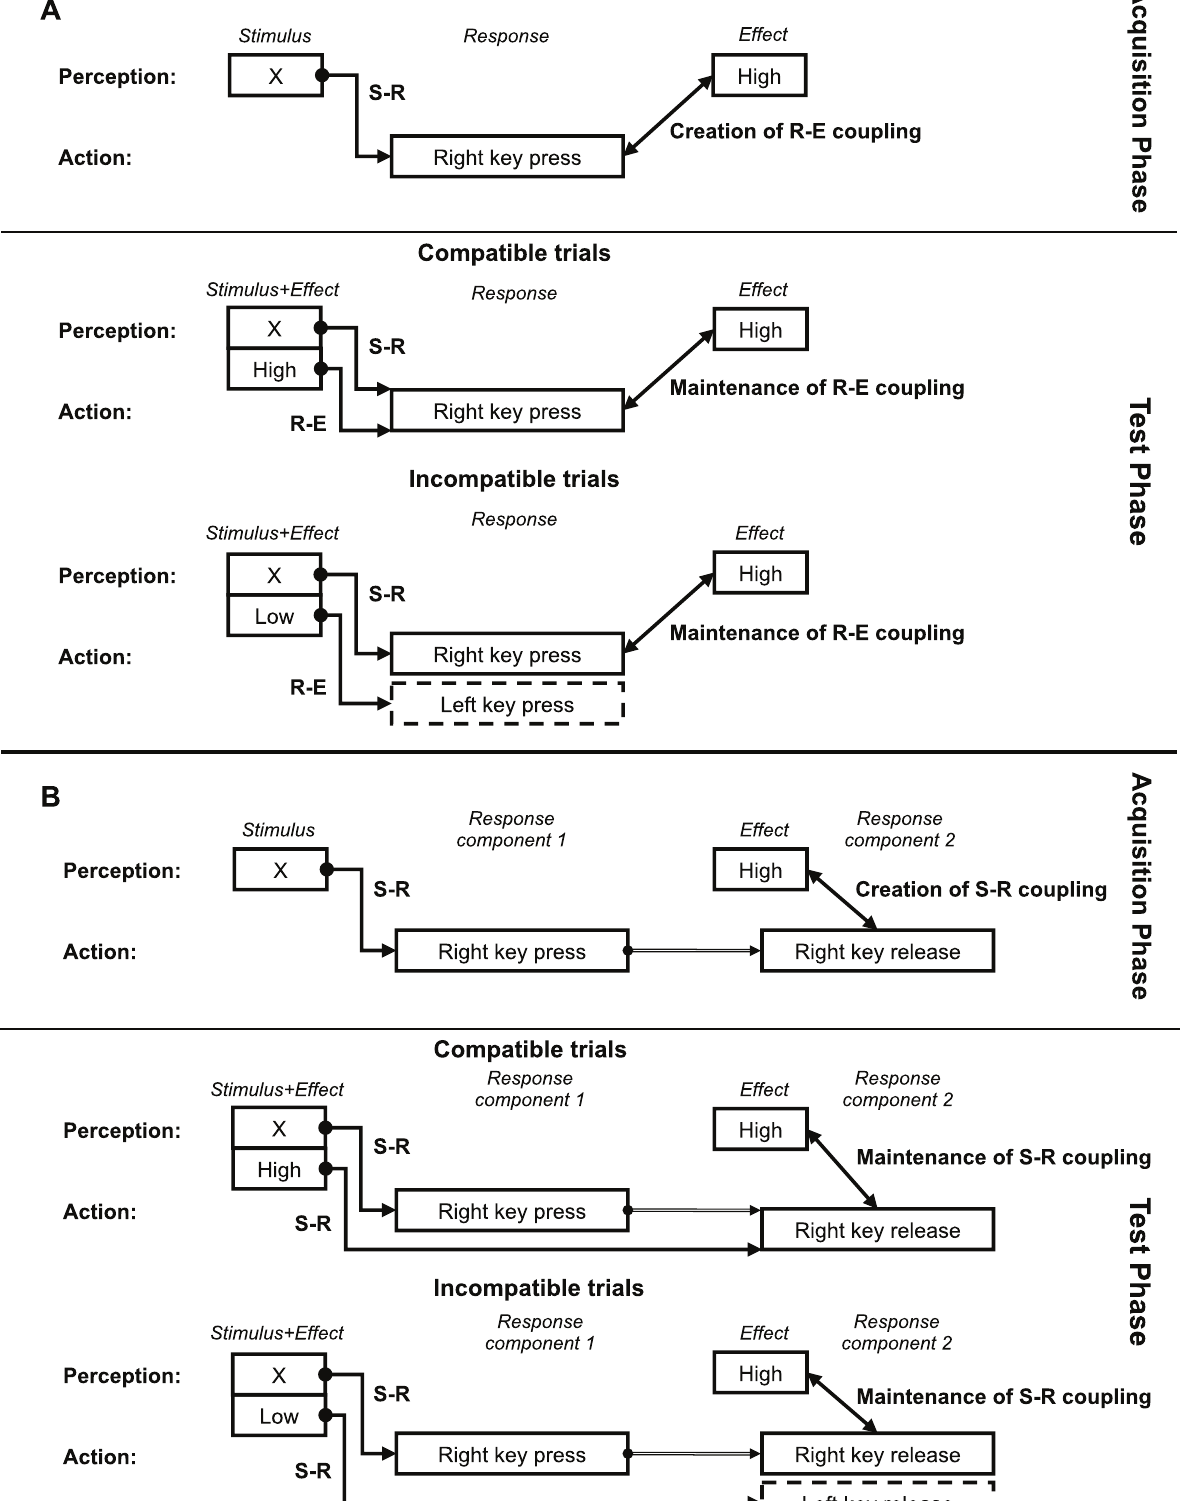
Figure 1. Outline of the two models. ( A ) Outline of the two-step model for the ideomotor principle (see e.g. [21]). Response-effect (R-E) couplings are established between key press and tone in the acquisition phase. This results in response facilitation in the test phase when at stimulus presentation the matching tone (with respect to this stimulus) is sounded, but not when the other tone is sounded. ( B ) Outline of the alternative model based on stimulus-response (S-R) couplings established between Stimulus and Response component 1 and between Effect and Response component 2. The difference in response latencies between compatible and incompatible trials for both movements is accounted for by cooperation